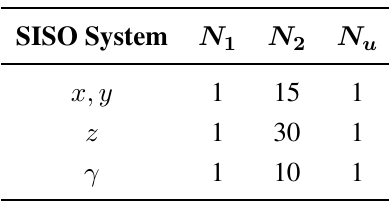
Design parameters for the extended prediction self-adaptive control (EPSAC) controllers. SISO, single-input single-output.